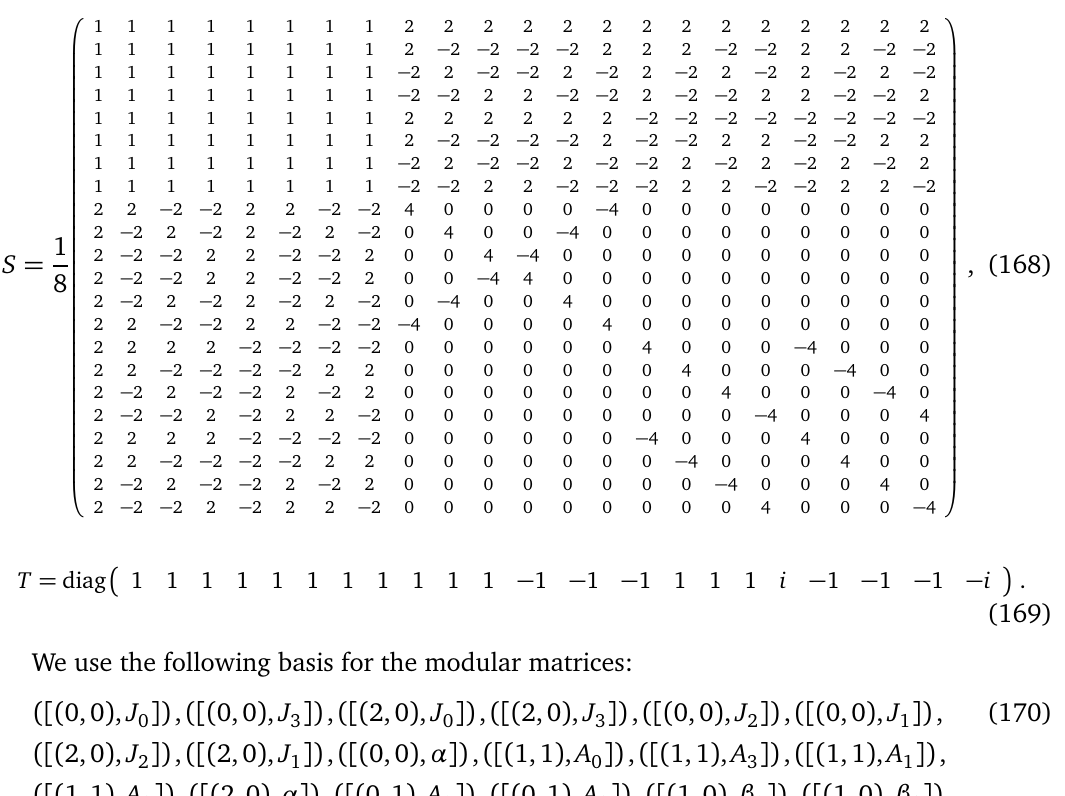
Figure 41: The cup product of α beled by stars) of their dual edges. More precisely, the right star corresponds to α ( 〈 01 〉 ) β ( 〈 13 〉 ) and the left star gives α 1 1 product Eq.